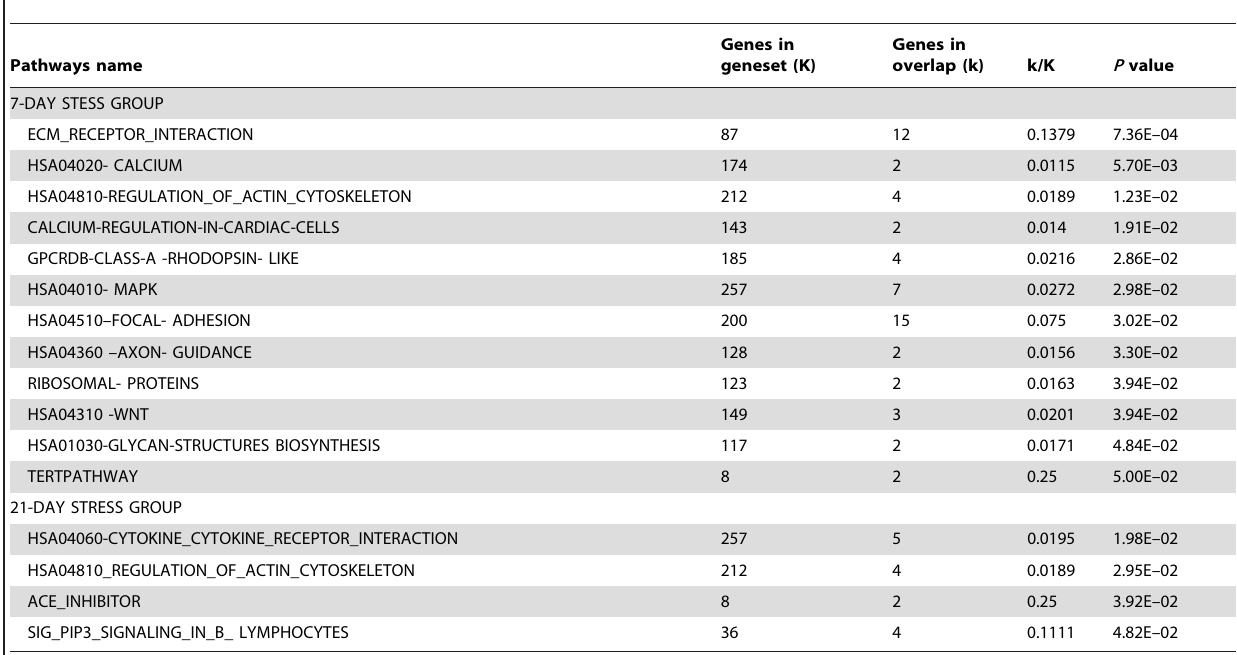
Table 2. Analysis of the differential gene pathways of the 7-day and 21-day stress groups in comparison with the control